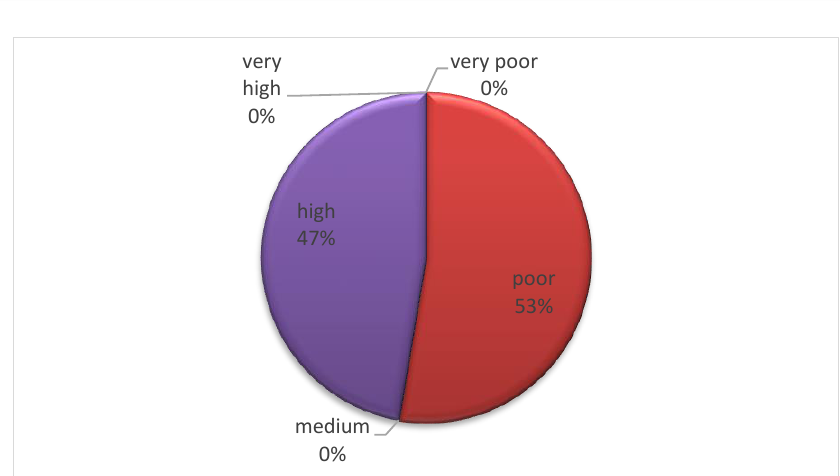
Figure 9. Baitussalam II Students’ HOTS based on Logic and Reasoning Indicator in Percentage Figure 9 indicates that Baitussalam students’ logic and reasoning was categorized low. There were 10 (53%) students who obtained poor scores on this indicator, with a score range of -29.58 < X ≤ 21.72. The highest score observed was 100, while the lowest was 0